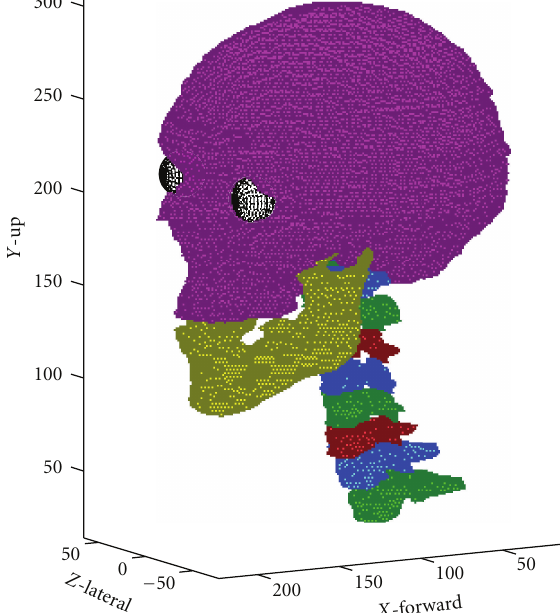
Figure 3: head-neck bony structure plus eyes with anatomical data from the visible human. Di ff erent colors are used to di ff erentiate di ff erent